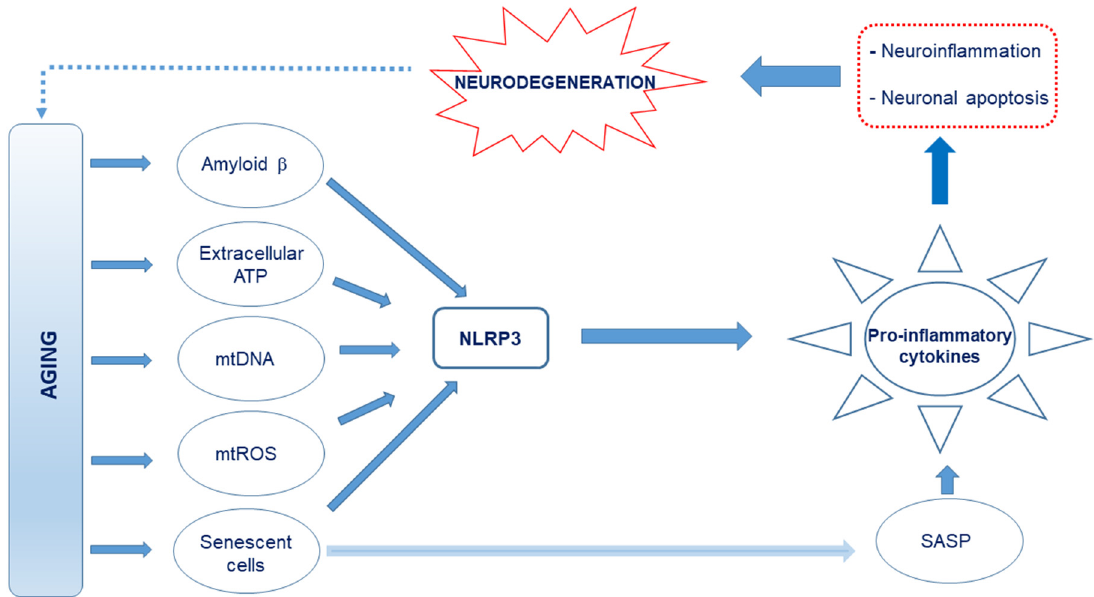
Figure 1. Schematic representation of the proposed causes of neuroinflammation in Alzheimer’s disease (AD). Age-related release of damage-associated molecular patterns (DAMPs) such as A β , extracellular ATP, and cell debris such as circulating mitochondrial DNA, which are capable of interacting with the Nod-like receptor 3 (NLRP3), creates an oxidative and neuroinflammatory environment through the excessive production and release of pro-inflammatory cytokines and reactive oxygen and nitrogen species (RONS). Further, mitochondrial reactive oxygen species (mtROS) and senescence-associated secretory phenotype (SASP) factors from the senescent cells, which also drive senescence in nearby cells, produce pro-inflammatory cytokines. This culminates in neuroinflammation and neuronal apoptosis.